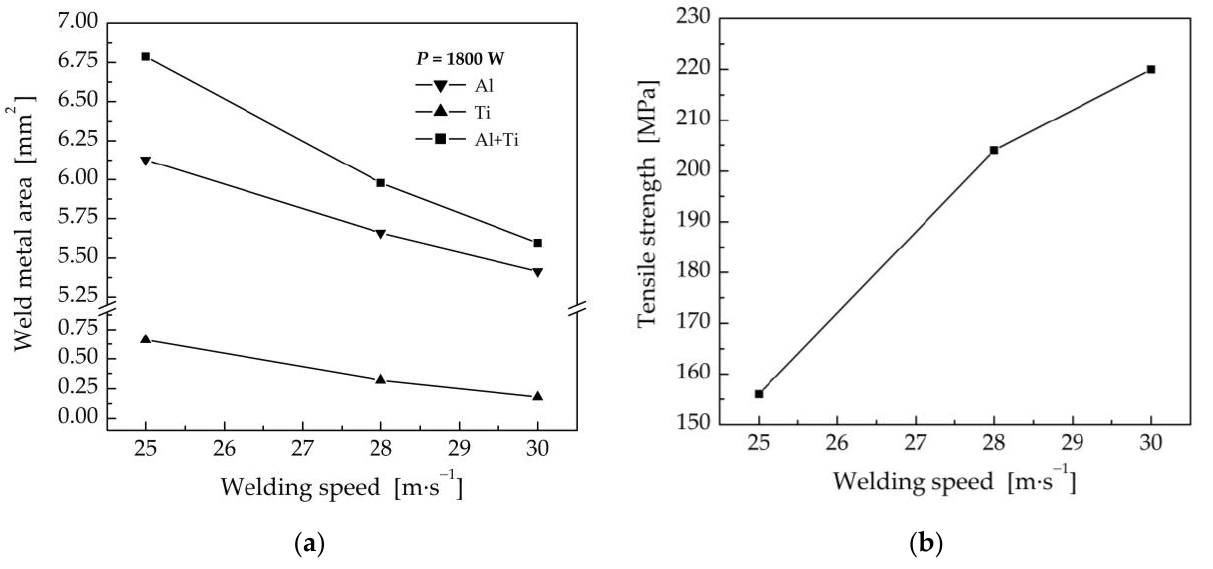
Figure 18. Effect of welding speed on the weld metal area and the ultimate tensile strength of the weld joints prepared with a laser power of 1800 W and a laser beam offset of 300 μm .